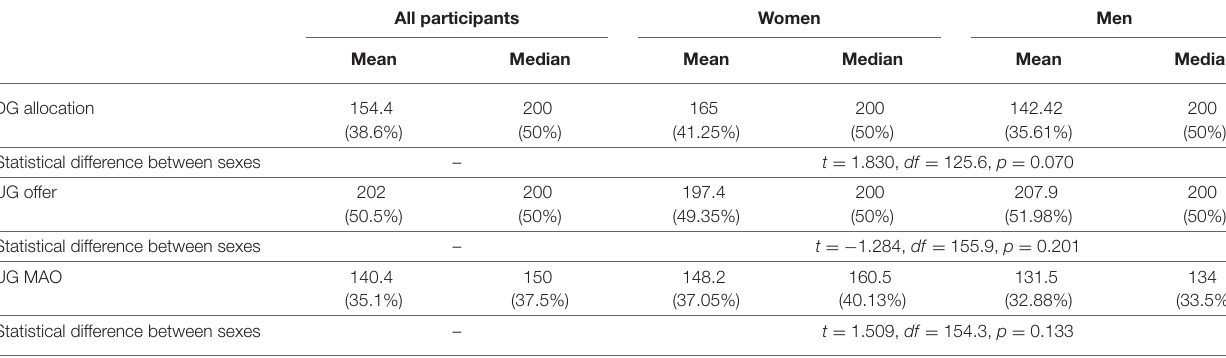
TABLE 1 | Gender differences in DG and UG responses.